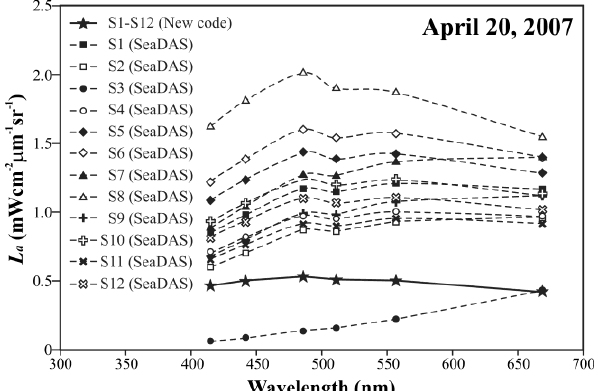
Figure 10. Comparison of aerosol radiance ( L the 12 sites in Lac des Allemands for the OCM data of 20 April